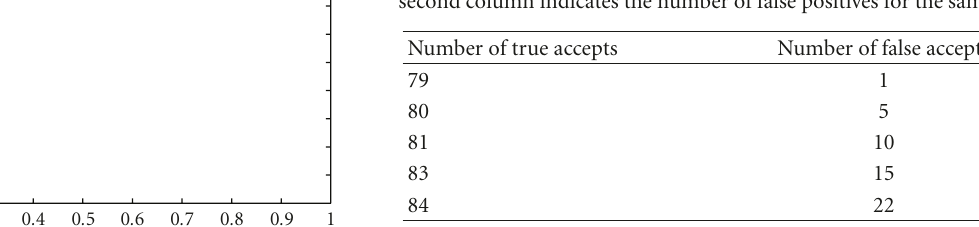
Table 1: Useful values for visualization of result depicted in Figure 21. The first column indicates the number of true positives for increasing values of thresholds in the iris similarity metric. The second column indicates the number of false positives for the